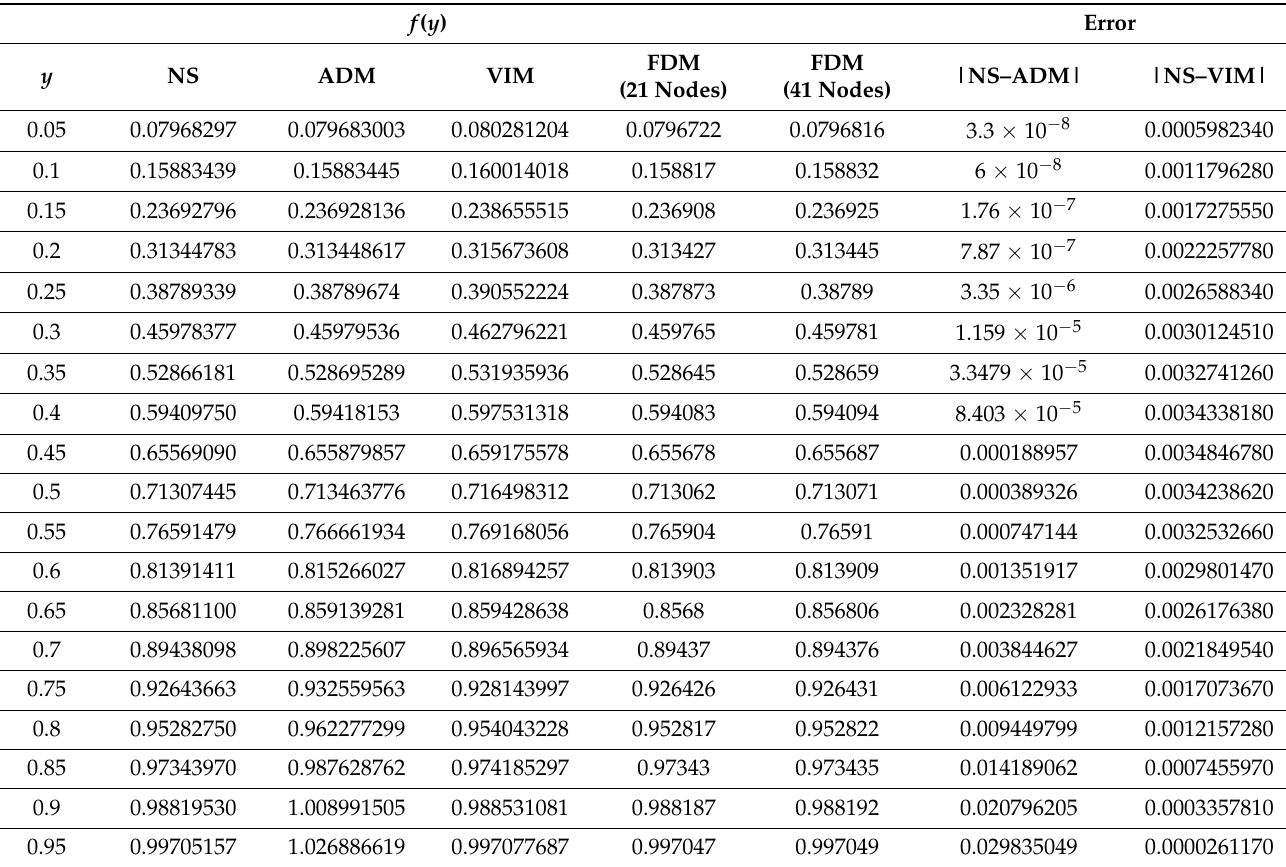
Table 4. Comparison of the numerical solution (NS) with the ADM, VIM and FDM for the case of Re = 5 and α =